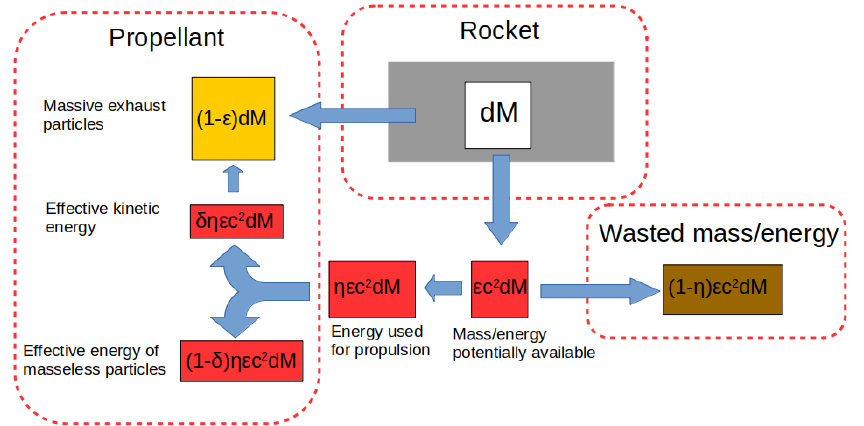
Figure 2. Energy scheme calculated in the rocket space frame. The total infinitesimal mass dM lost by the rocket is related to the rest mass of the accelerated particles, their energy and the energy of the massless expelled particles. Energy that is not used to accelerate the rocket is considered wasted